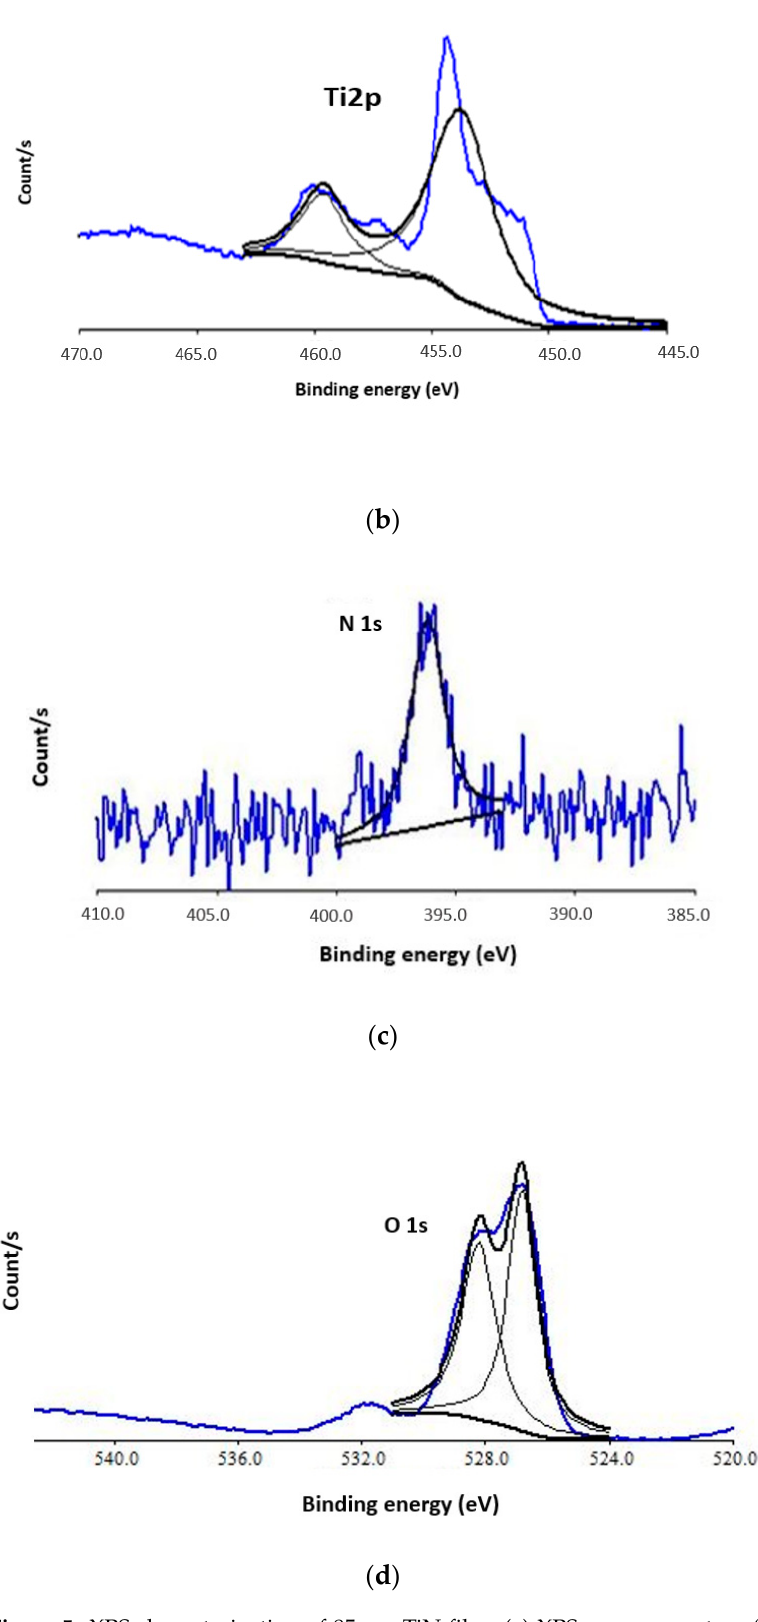
Figure 5. XPS characterization of 85nm TiN film: ( a ) XPS survey spectra of the unetched 85nm sputtered TiN film ( b ) XPS spectrum of 2p states of titanium ( c ) XPS spectrum of 1s states of nitrogen ( d ) XPS spectrum of oxygen .